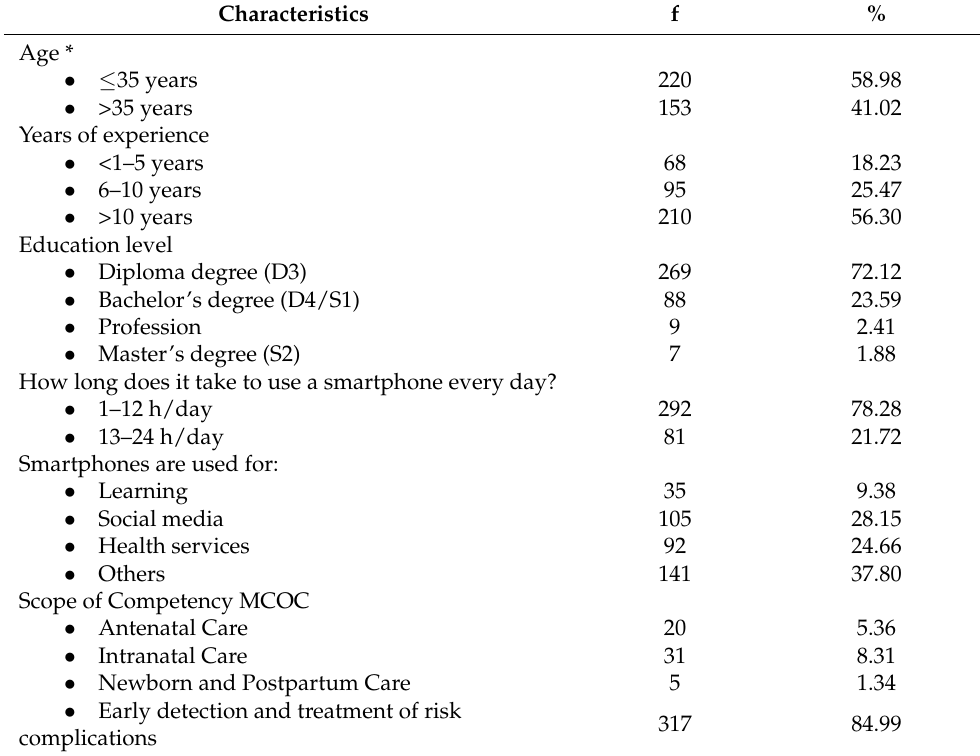
Table 2. Characteristics of midwives.